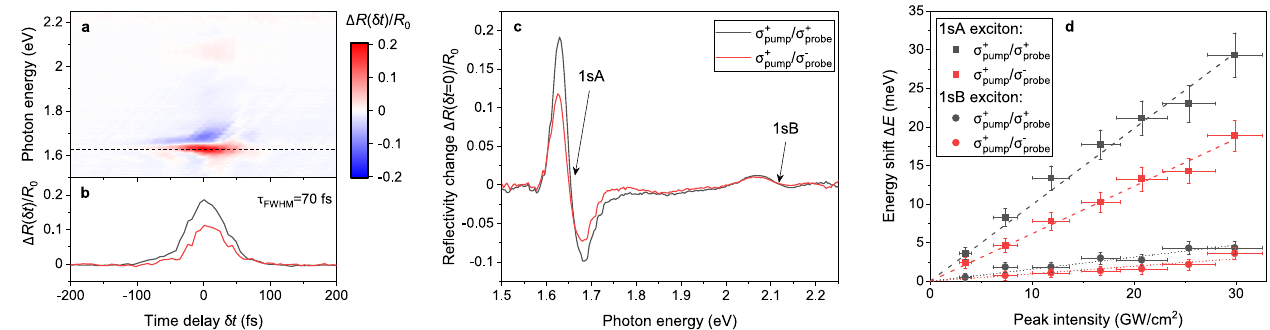
Fig. 2 Transient re fl ectivity spectra of WSe 2 monolayer. a Transient re fl ectivity spectra of WSe 2 monolayer Δ R ( ℏ ω , δ t )/ R 0 ( ℏ ω ) as a function of the time delay between pump (photon energy of 0.62 eV) and broadband probe pulses both of the same circular polarization handedness. b Pro fi le of the signal in time-domain for the same (black curve) and opposite (red curve) circular polarization handedness of the pump and probe pulses. c Transient re fl ectivity spectrum at zero time delay for peak intensity of the pump pulse of 30 GW/cm 2 . d Maximum energy shift obtained from the measured spectra at zero time delay as a function of the peak intensity of the pump pulse for 1sA and 1sB excitonic resonances. Black/red dashed and dotted curves represent the linear fi tting of the OS/BS shifts of 1sA and 1sB excitons, respectively.